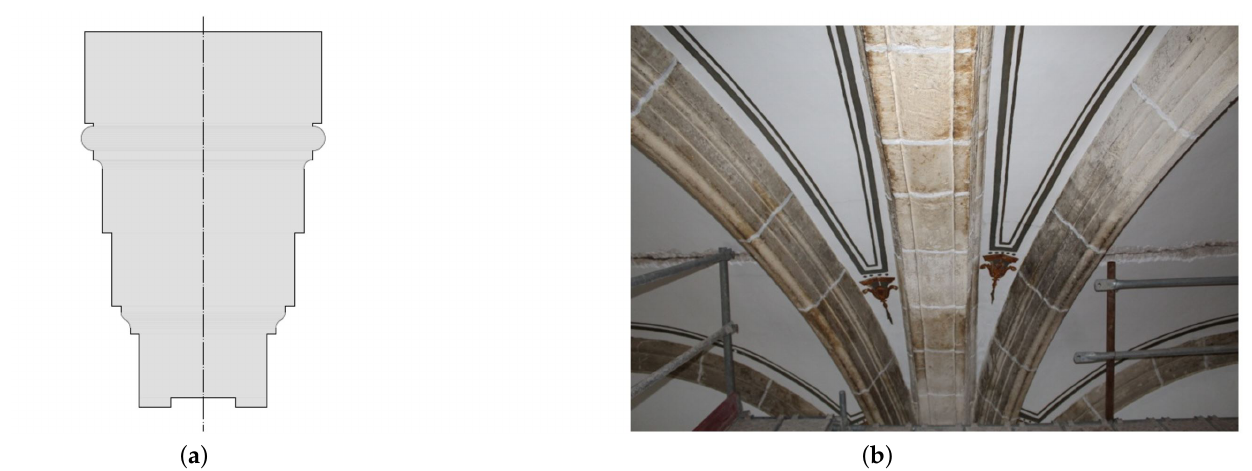
Figure 9. ( a ): Typical cross-section of the transverse arches. ( b ): transverse and diagonal arches (in addition to the former arches).